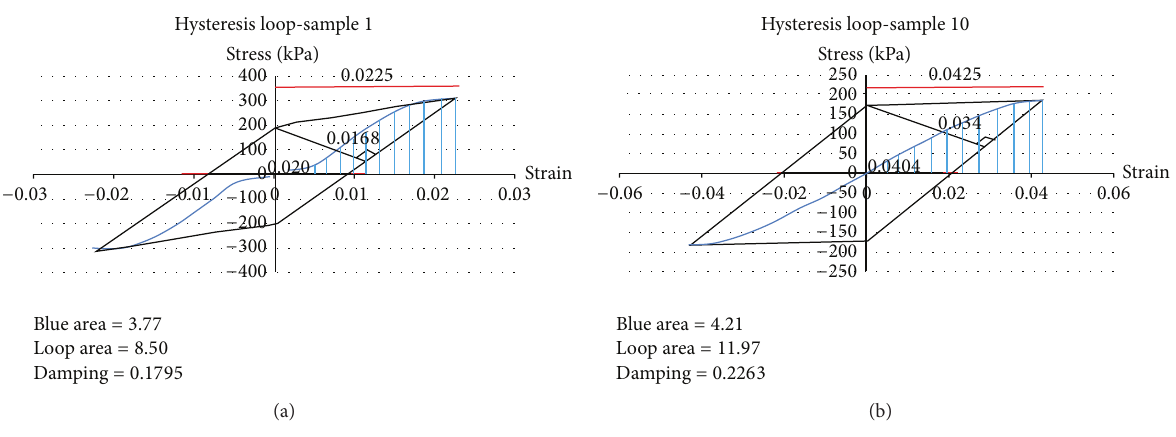
Figure 10: Estimation of damping ratio: (a) sample 1 and (b) sample 10.